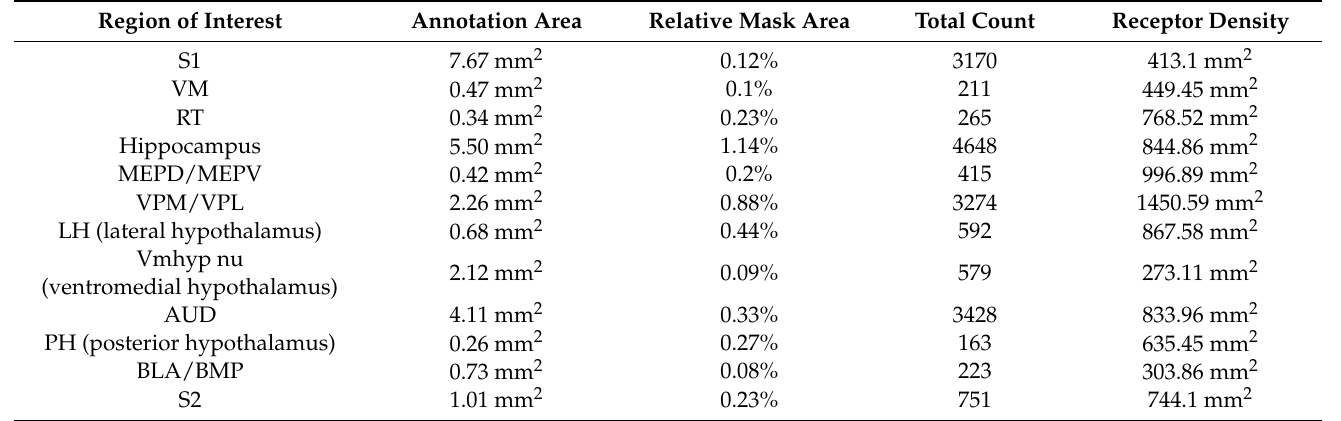
Table 1. Melatonin receptor distribution in regions of the